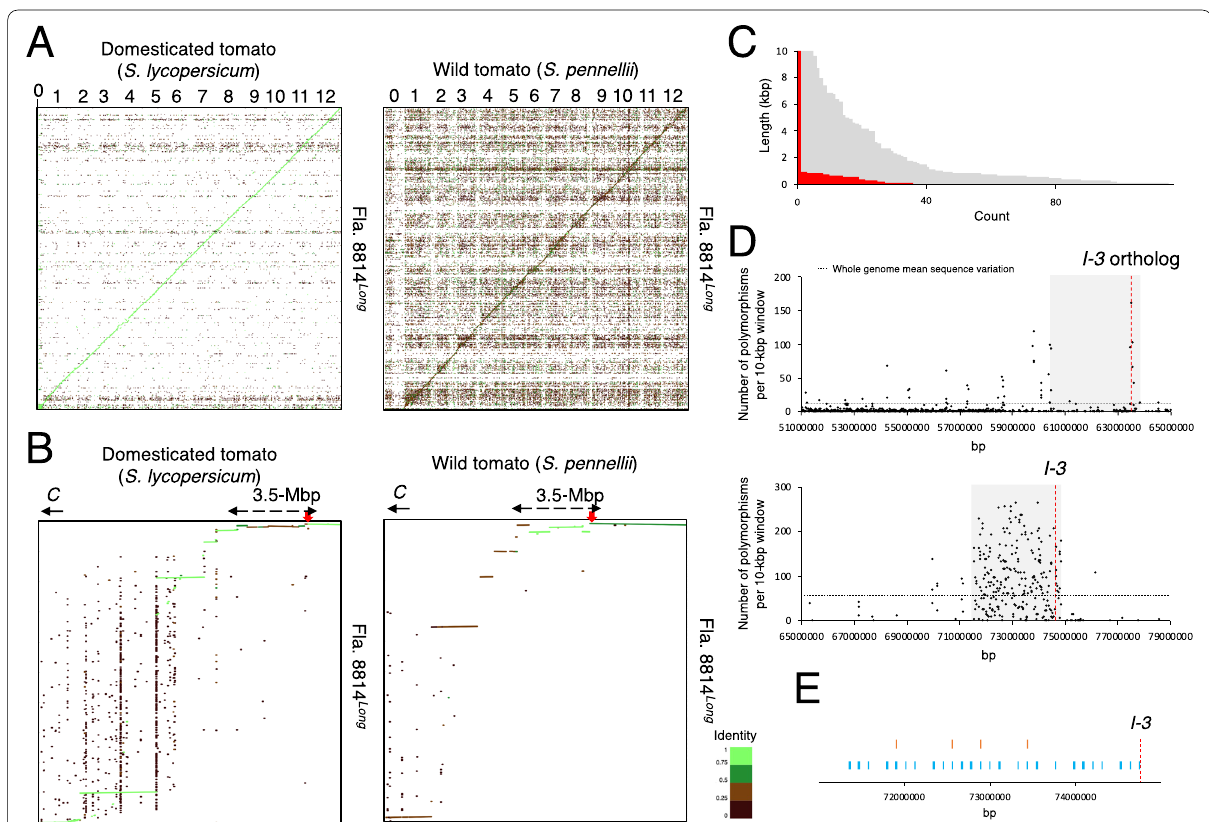
Fig. 1 Sequence characterization of the Fusarium wilt resistance I-3 flanking fruit size reducing region. A Dot plot comparison between the reference genome (horizontal) and contigs of Fla. 8814 Long (vertical) ( A and B ). Numbers represent the tomato chromosomes. Sequence similarity is color coded from 0 to 1 ( A and B ; The summary of identity is placed next to B ). B Zoomed in plots (a 14-Mbp interval) capturing the I-3 introgression on chromosome 7. Inferred I-3 introgression (approximately 3.5-Mbp) is depicted by dash arrows. Red arrows indicate the position of the I-3 gene. C : centromere. C Length distribution of 115 gaps found in a 4-Mbp interval of the wild tomato genome carrying the I-3 introgression (gray color) and 36 gaps overlapped by contigs (red color). D Common sequence variant density plot of the Fusarium wilt resistance I-3 introgression. Top and bottom panels show common sequence variants on the basis of alignment to a reference domesticated tomato (i.e., sequence variant found in both Fla. 8814 Long and Fla. 8814 Short , but not in Fla. 8814 None ) and to a reference wild tomato (i.e., found in both Fla. 8814 Short and Fla. 8814 None , but not in Fla. 8814 Long ), respectively. Inferred I-3 introgression (approximately 3.5-Mbp) is depicted in gray. The approximate locations of I- 3 ortholog ( Solyc07g055640 between 63,514,724 and 63,521,342 bp; top panel in D ) and I-3 ( Sopen07g029010 between 74,627,845 and 74,630,497 bp; bottom panel in D and E ) are depicted by red lines. See Fig. S3 for the sequence variant density plot for each of Fla. 8814 Long , Fla. 8814 Short , and Fla. 8814 None . Physical positions are based on individual reference genomes. E Locations of structural variants (SVs) ( 50 bp in length) found in Fla. 8814 Long only ≥ as compared with orthologous DNA sequences (i.e., found in neither Fla. 8814 Short nor Fla. 8814 None ) (orange vertical bars) and found in both Fla. 8814 Short and Fla. 8814 None , but not in Fla. 8814 Long (blue vertical bars). Physical position is based on the reference genome of a wild